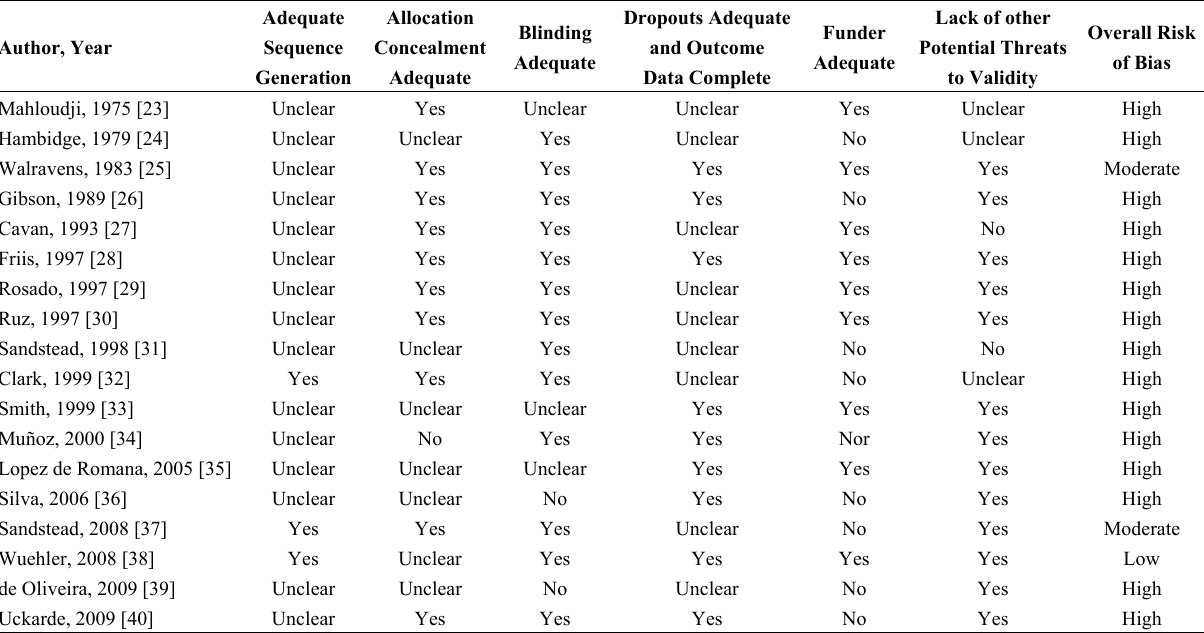
Table 3. Assessment of validity of included RCTs reporting zinc intake and serum/plasma zinc in children (adapted from the Cochrane Handbook